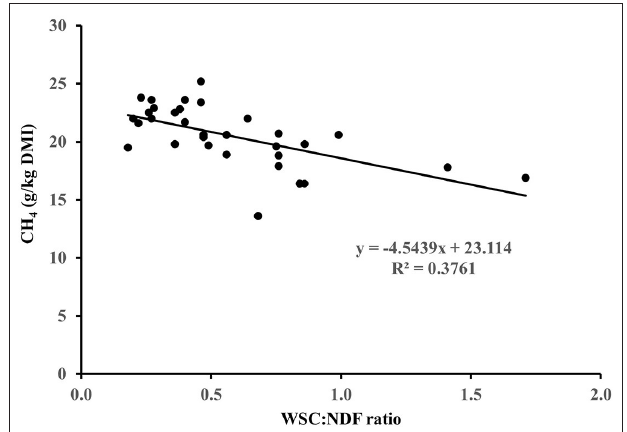
FIGURE 1 | Relationship between CH 4 yield (g/kg dry matter intake; DMI) and forage water soluble carbohydrate (WSC): neutral detergent fibre (NDF) ratio in sheep fed different fresh